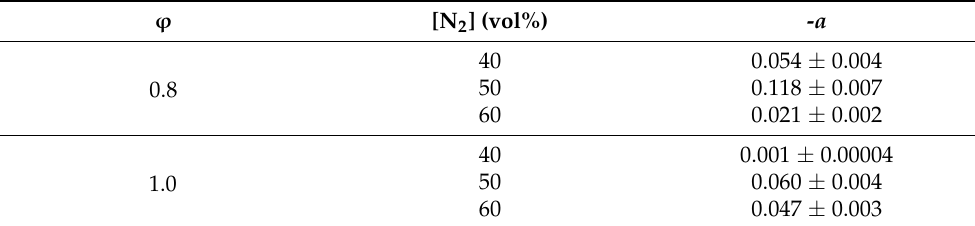
Figure 8. Propagation speeds of lean and stoichiometric CH 4 -N 2 O-N 2 mixtures. Table 6. Baric coefficients of the propagation speeds of CH 4 -N 2 O-N 2